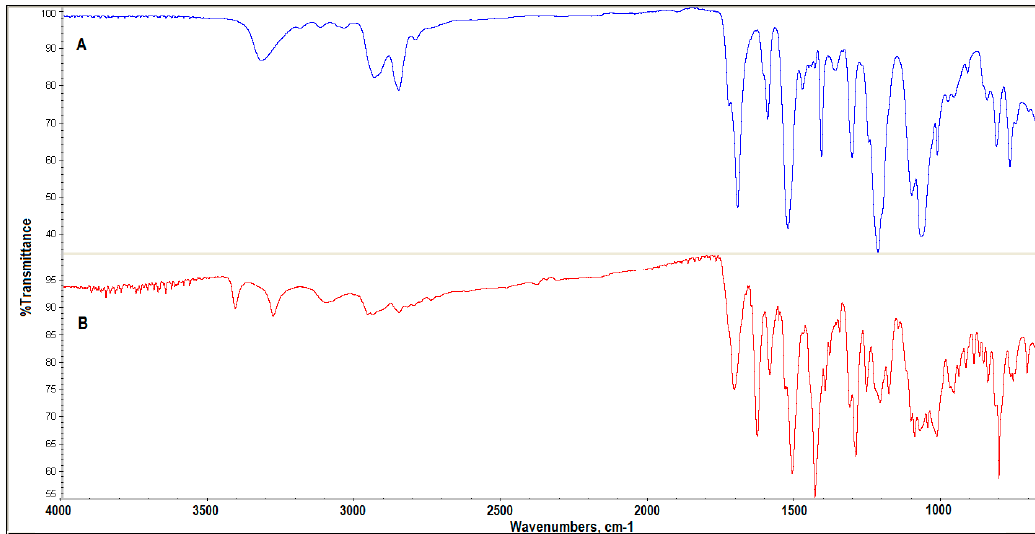
Figure 4. Comparison of the polyurethane catheter before ( A ) and after ( B ) immobilization of SPA .